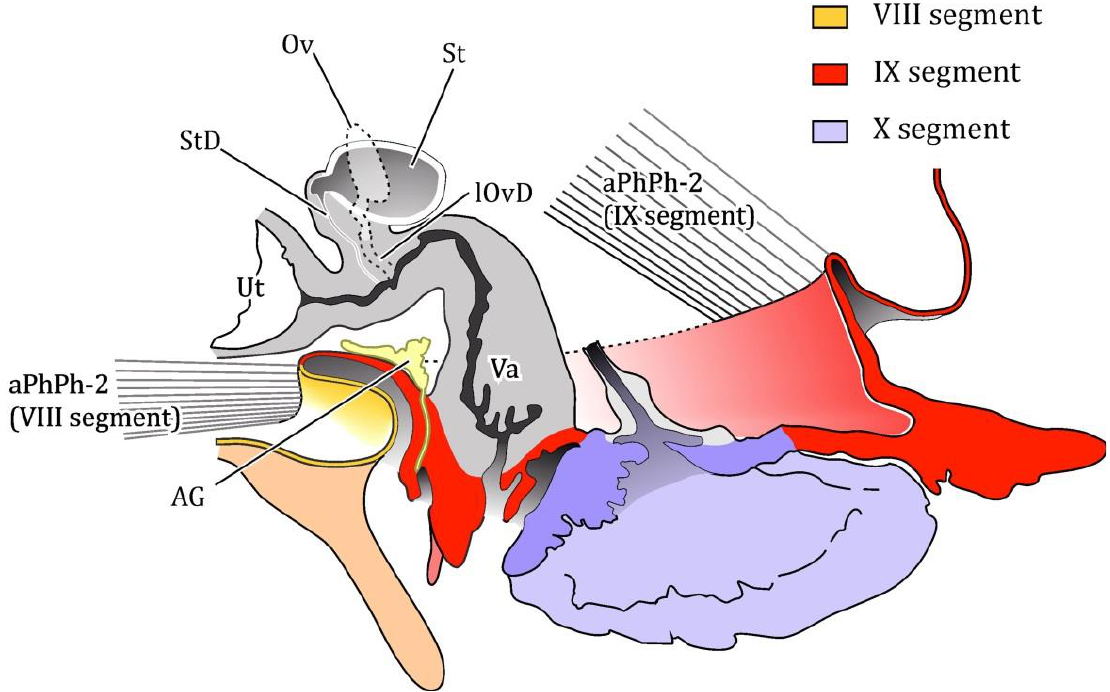
Figure 13. Platerodrilus svetae , female, median section of VIII-X segments and reproductory system. Explanations in text.